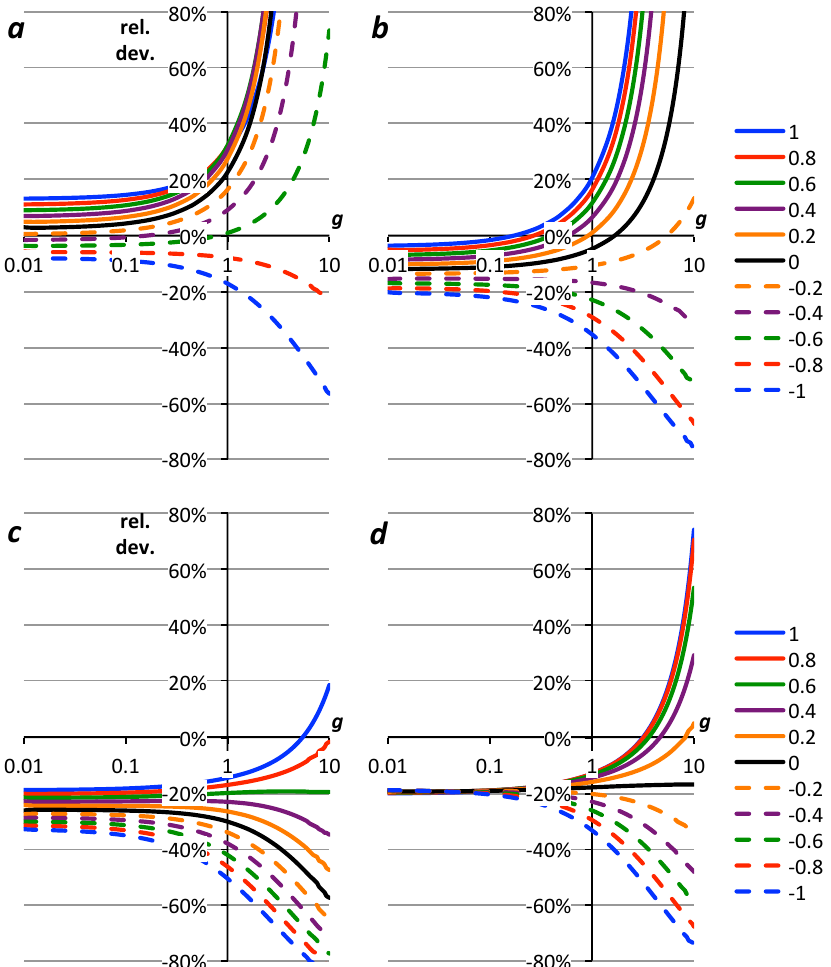
Fig. 4. Relative deviation of the approximated solution for g (Eq. 10) from the accurate solution (Eq. 1) for the parameters in Table 1, row 3a ( Acropora (flask), 18 ε P = 0.5‰